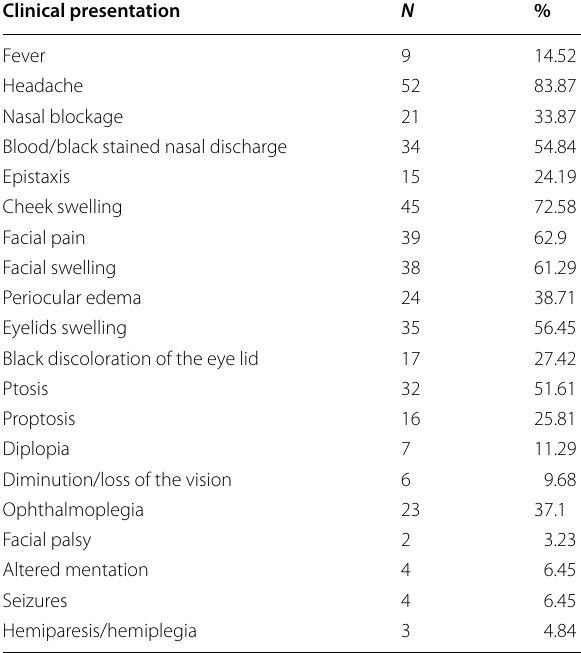
Table 2 Clinical presentation for the studied group